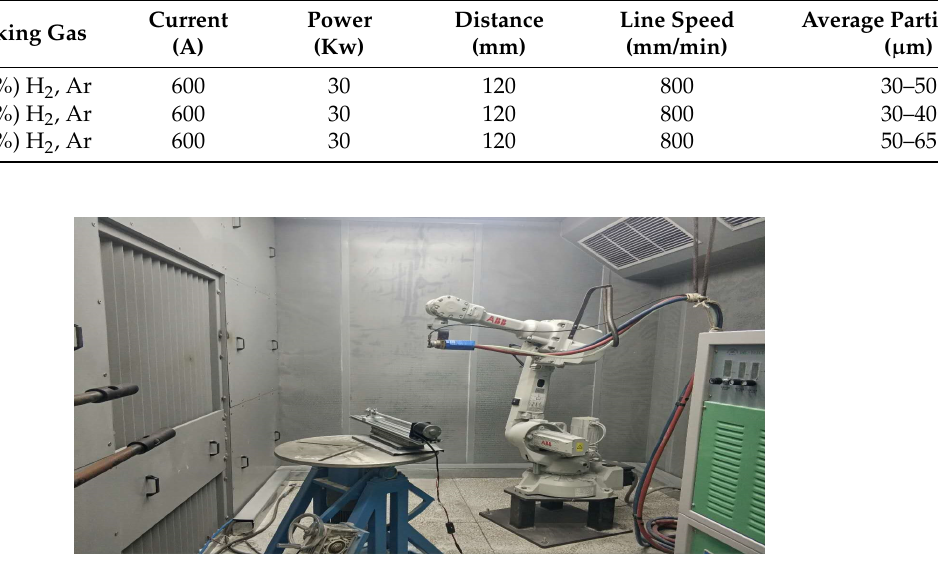
Figure 1. Atmospheric plasma-spraying equipment.